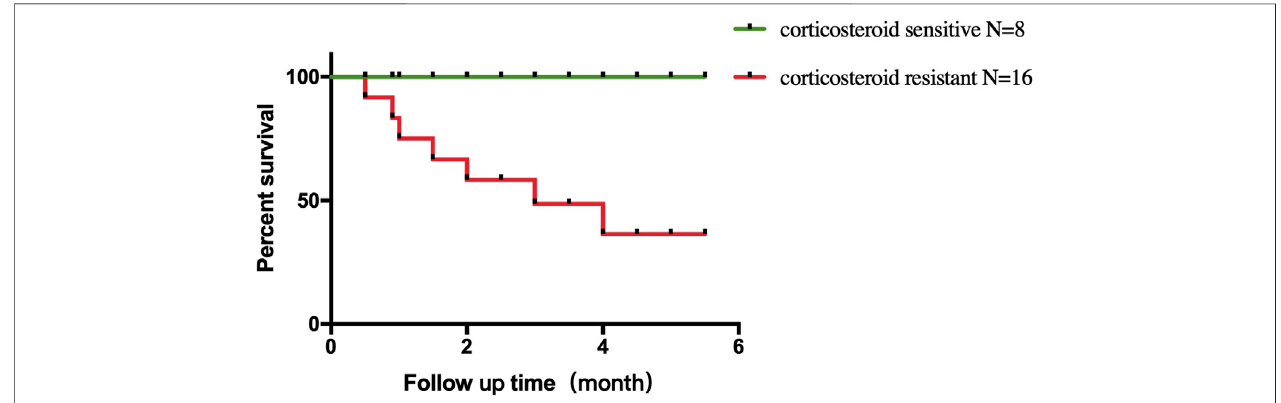
FIGURE 3 | Comparison of survival curves. Higher mortality in corticosteroid-resistant patients compared with corticosteroid-sensitive patients.